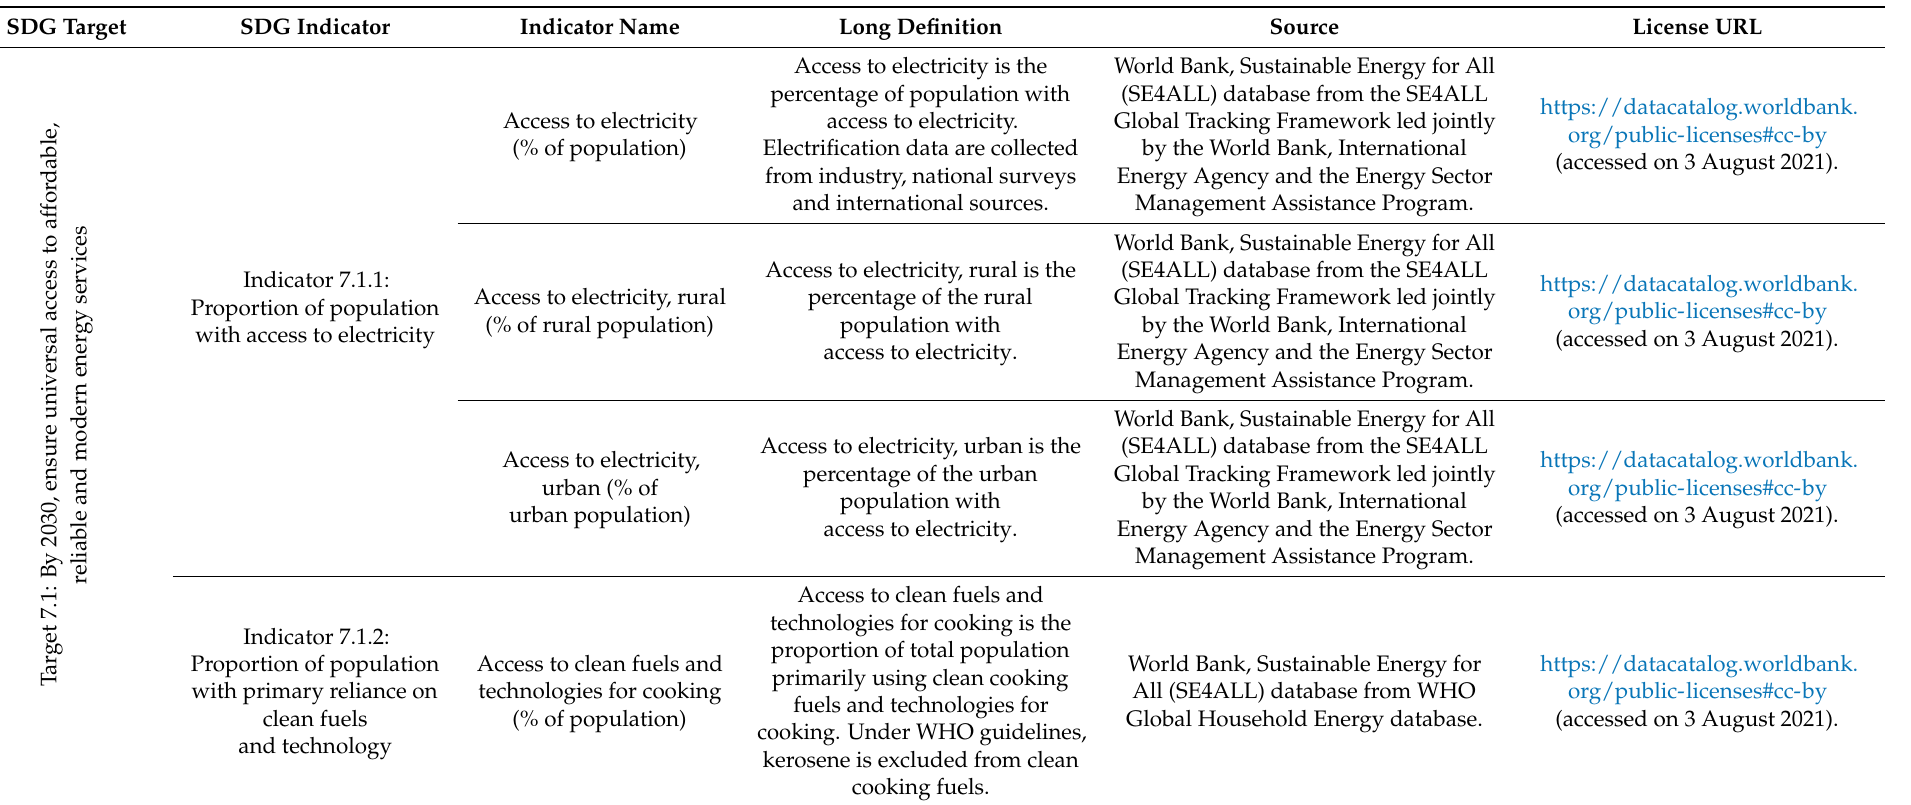
Table 2. Indicators for Sustainable Development Goal